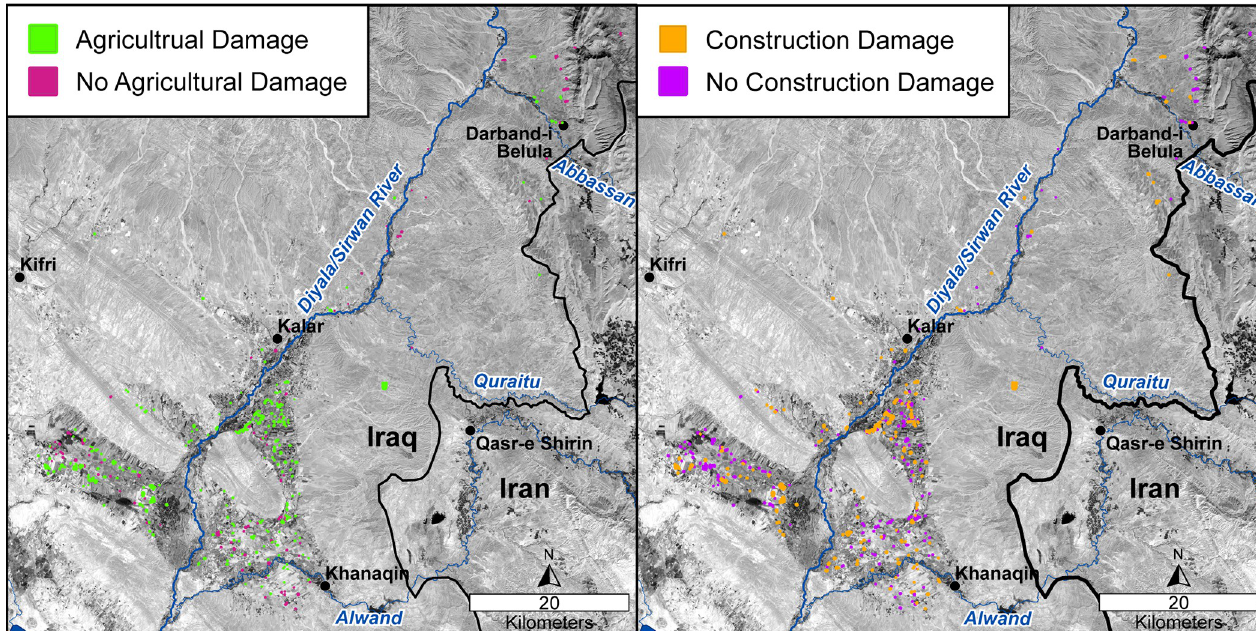
Fig 5. Map of sites with agricultural (left) and construction (right) damage. The basemap is Landsat 8 panchromatic imagery (acquired 4 October 2021) freely downloaded from http://earthexplorer.usgs.gov (courtesy of the USGS and NASA).